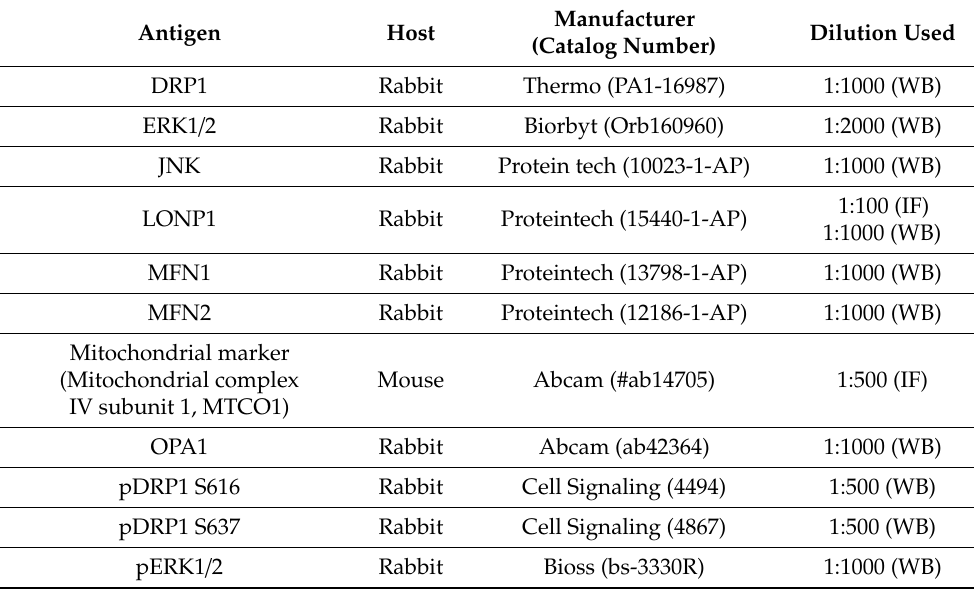
Table 1. Primary antibodies used in the present